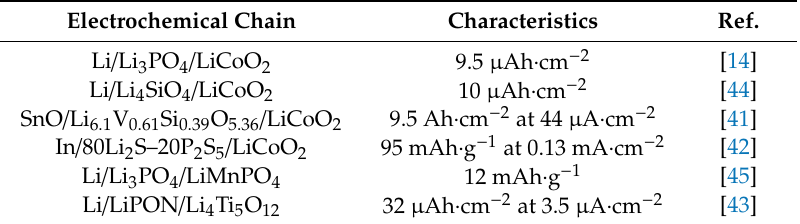
Table 3. Solid-state lithium microbatteries fabricated by the PLD